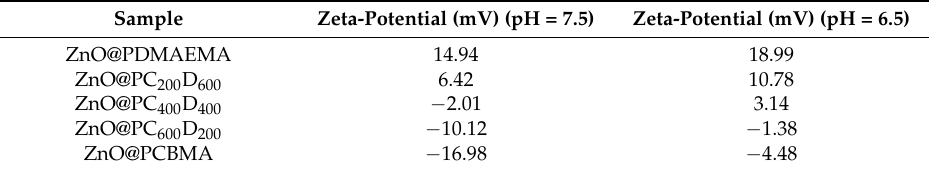
Figure 4. ( a ) Zeta potential of the ZnO NDDSs at different pH; ( b ) absorbance at λ = 600 nm showing the turbidity of the NDDSs incubated in 10% FBS with different times (0, 1, 2, 3, 4, 5, 6, 8, 10, and 15 days). Table 2. Zetal potential and drug loading contents of the NDDSs.